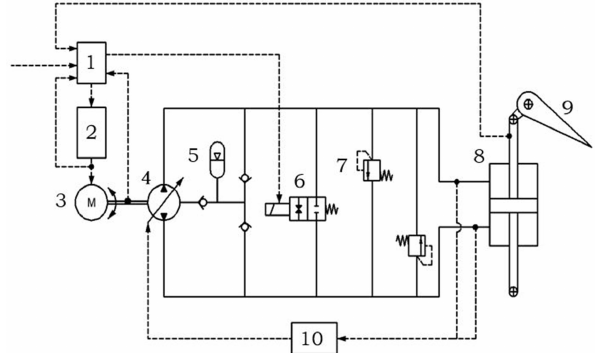
Figure 5. Schematic diagram of the HPLS-EHA: (1) EHA con- troller; (2) power drive unit; (3) brushless DC motor; (4) hydraulic pump; (5) energy accumulator; (6) damping bypass valve; (7) pres- sure relief valve; (8) actuator cylinder; (9) control surface; (10) dis- placement